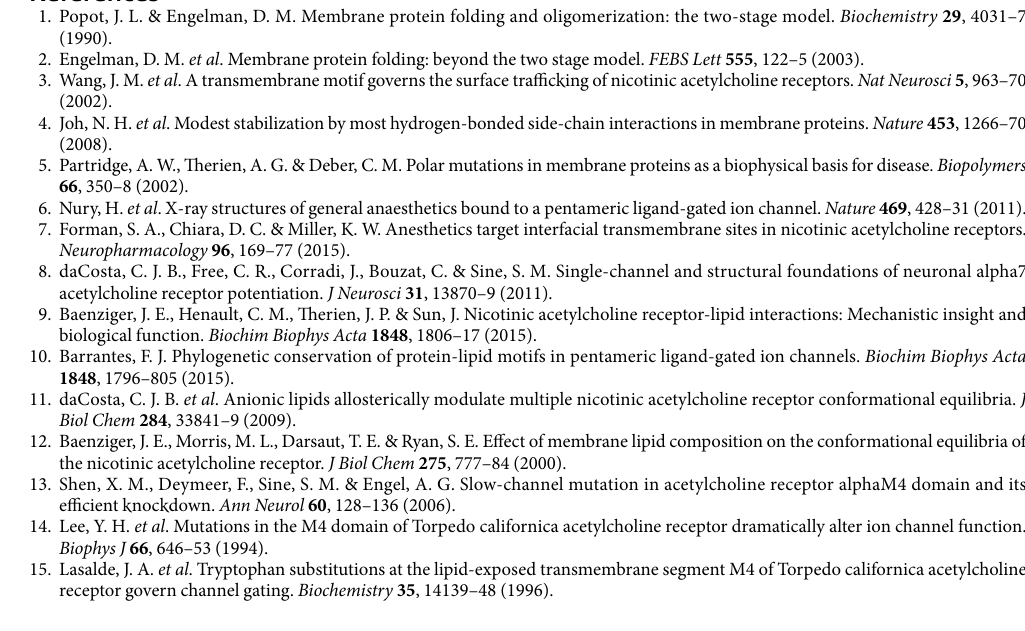
12 Scientific RepoRts | 7: 450 | DOI:10.1038/s41598-017-00573-2